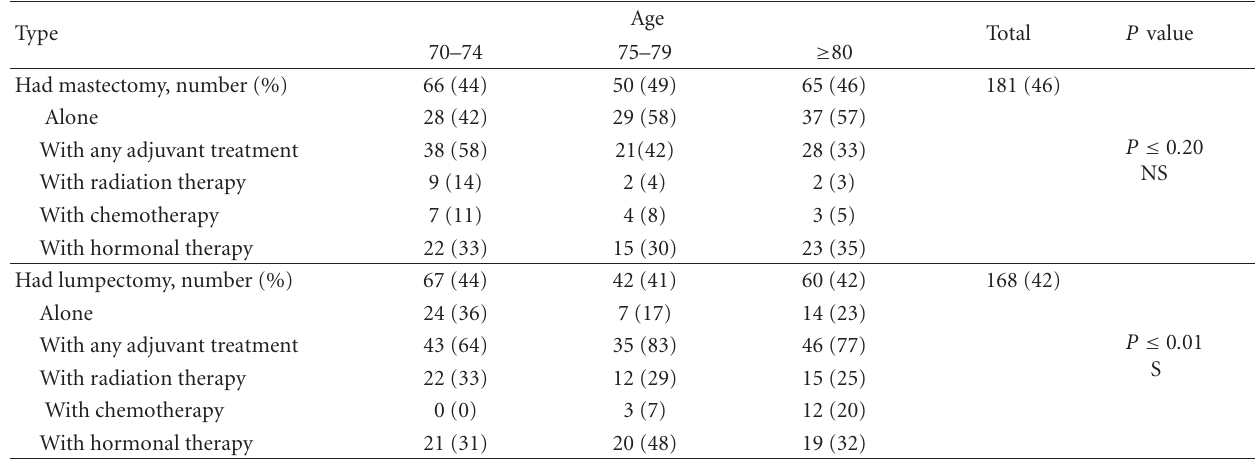
Table 2: Type of surgery and adjuvant treatment (1989–1999).